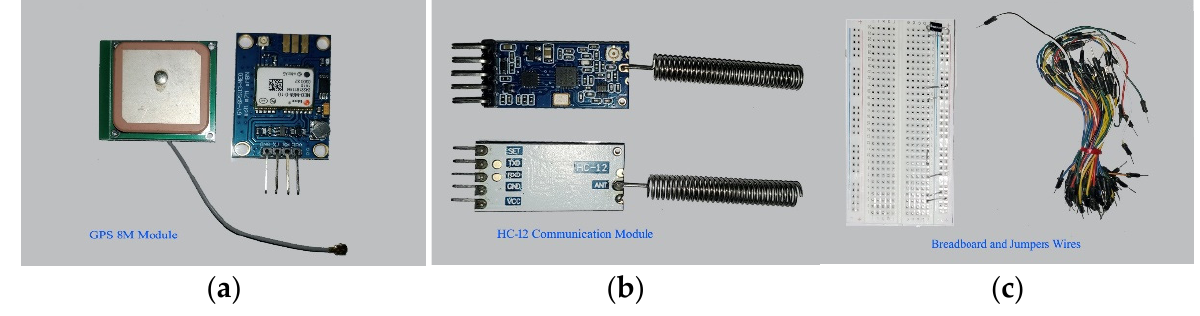
Figure 6. ( a ) GPS 8M module [62]; ( b ) HC-12 module [63–65]; ( c ) breadboard and jumper wires [56].